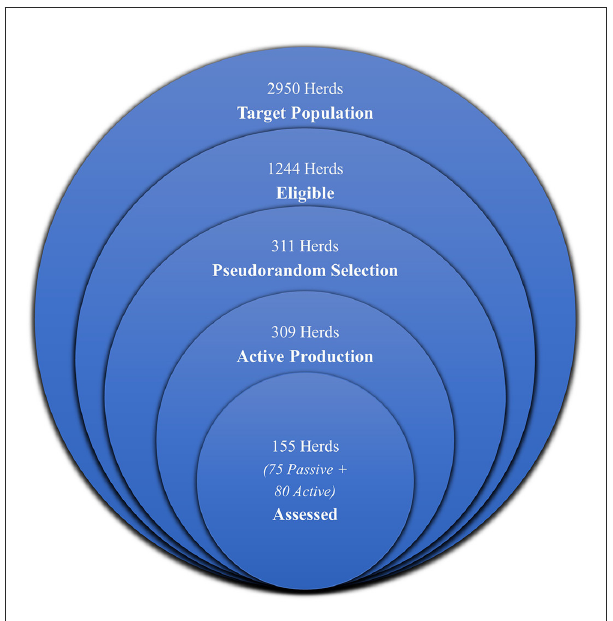
FIGURE1 Euler diagram visualizing the selection and recruitment process.